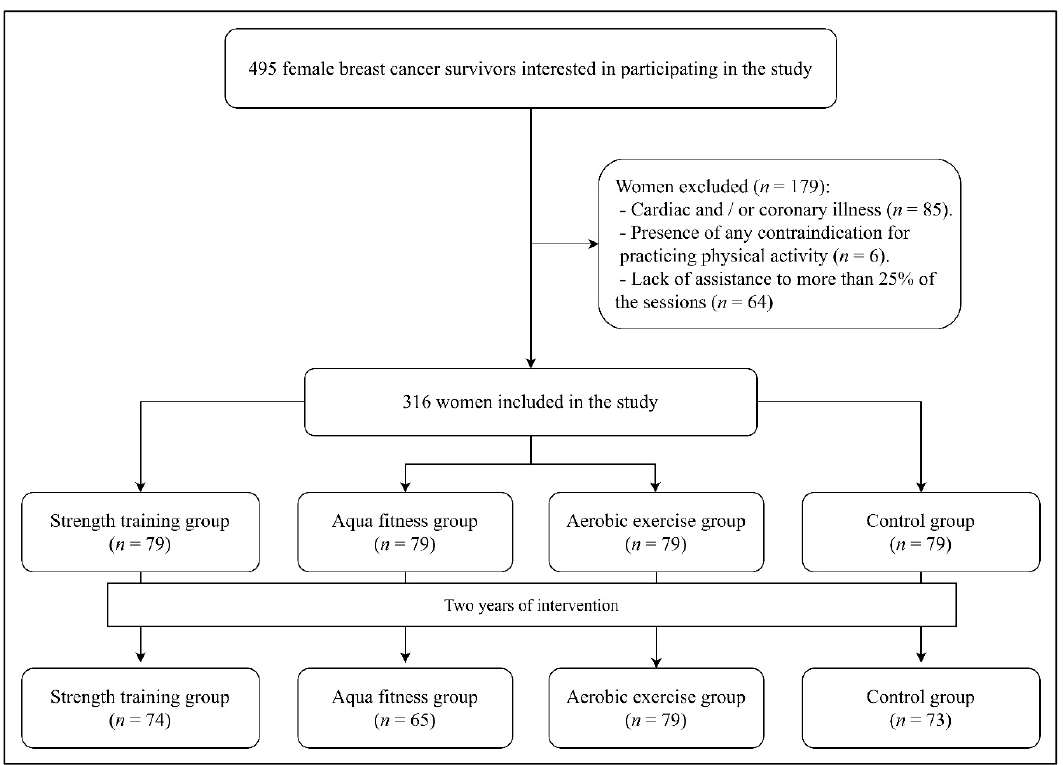
Figure 1. CONSORT flow diagram.